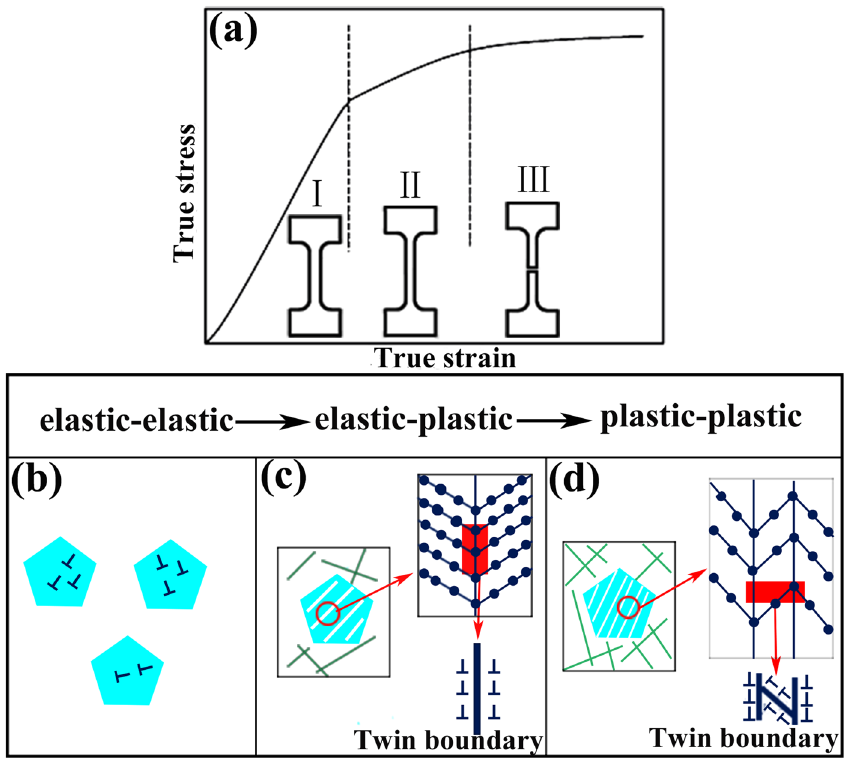
Figure 9. ( a ) True stress-strain curve illustrating the deformation behavior of the present composites, and the corresponding changes during deformation shown in inset. The deformation processes ( b ), ( c ), and ( d ) in the three stages corresponding to the (I), (II), and (III) in Fig.